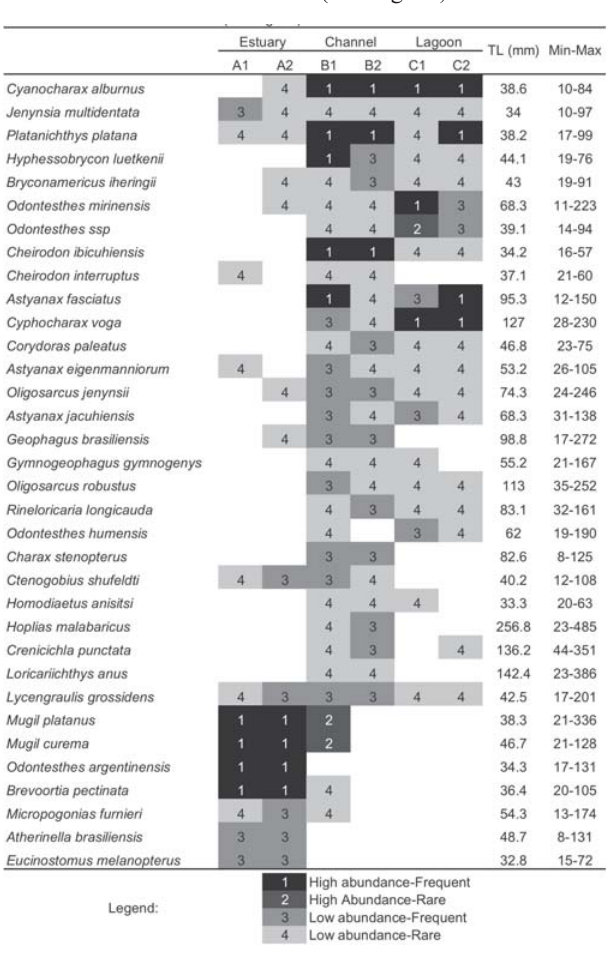
Table 1. Relative importance based on frequency of occur- rence (FO%) and percentual abundance (PN%) of the domi- nant fishes captured in the studt area (A: Patos lagoon estu- ary; B: São Gonçalo channel; C: Mirim lagoon). A total of 43 species, mainly freshwater fishes, showing only category 4 (Low Abundance and Rare) were not included. TL: average Total Length in mm. Min-Max: minimum and maximum total length. See legend below for categories’ interpretation. Be- tween B1 and B2 there is a dam (See Fig. 1b).